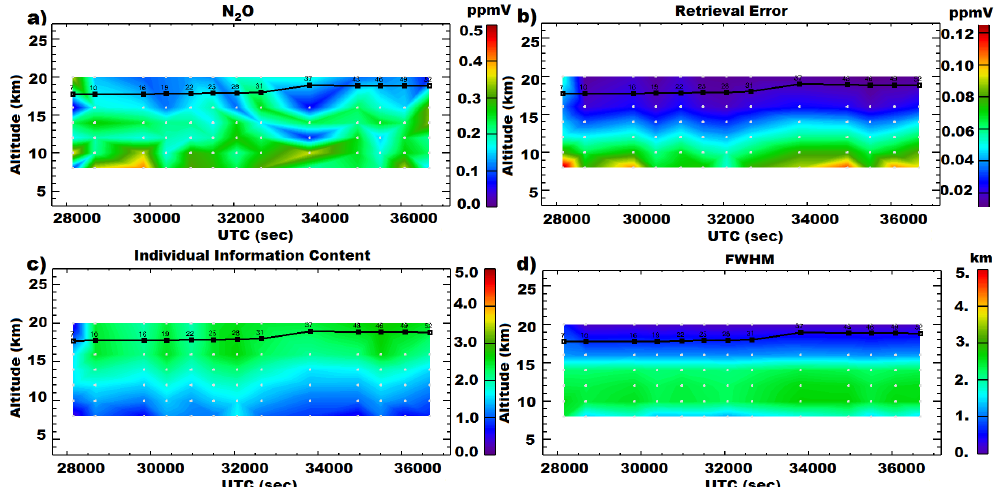
Fig. 13. As in Fig. 5 but for N 2 O retrieved from band B.